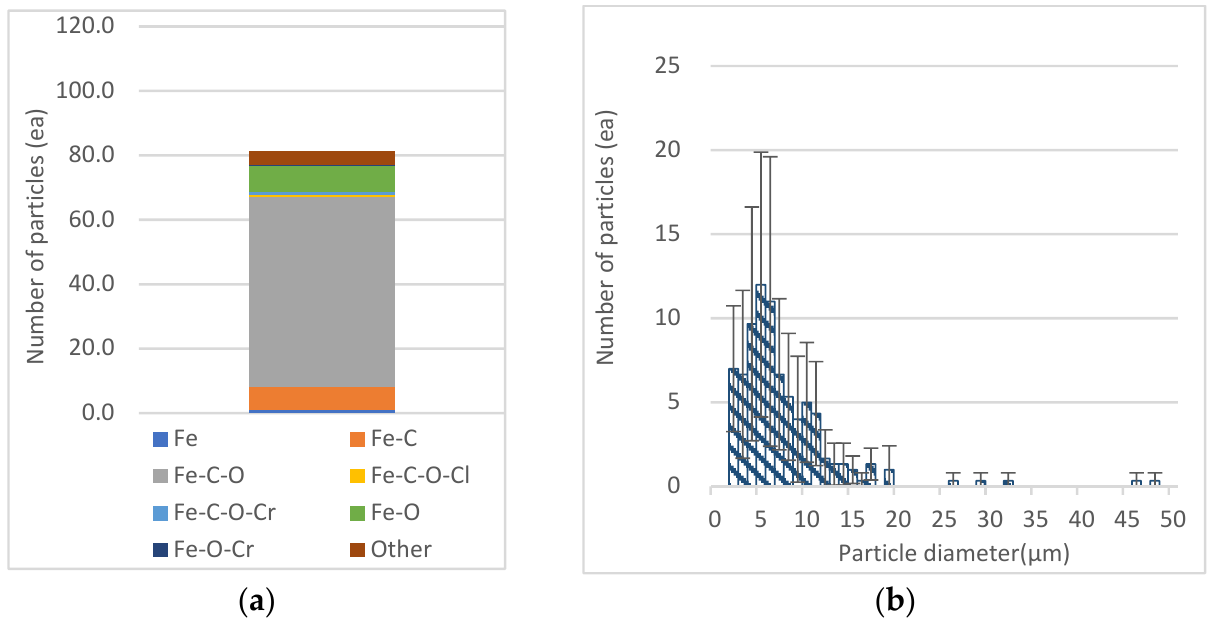
Figure 5. Composition of chemical categories and number of total Fe particles: ( a ) Composition of chemical categories; ( b ) number of total Fe particles by aerodynamic diameter ( μ m).